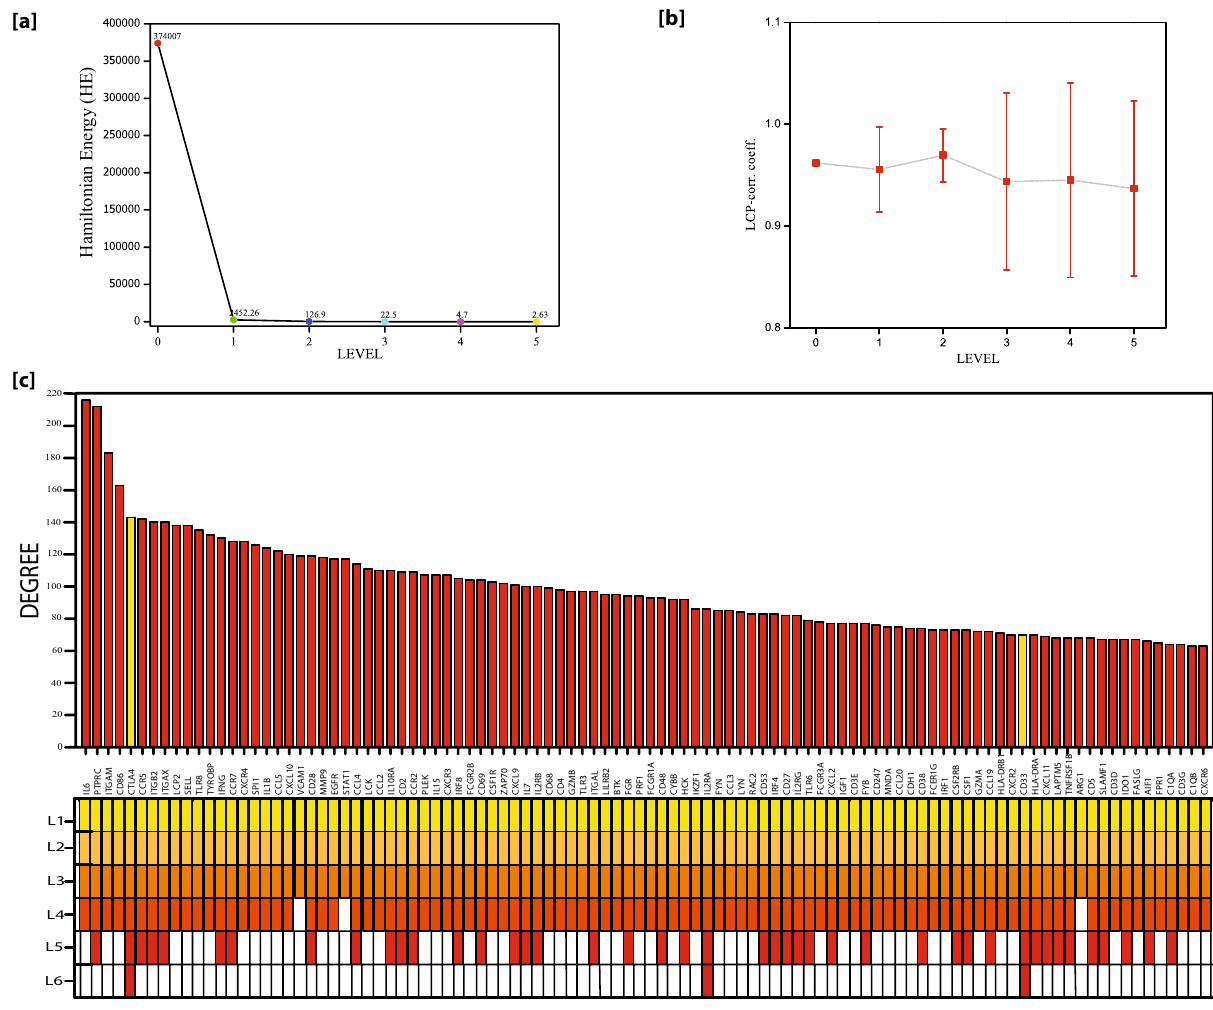
Figure 4. ( a ) Plots of Hamiltonian Energy as a function of level of organization. ( b ) Plots of LCP-corr as a function of the level of organization. ( c ) Characterization of top hundred leading hubs in the complete network by degrees; the plot also indicates unpredictability of these leading hubs at various levels of the organization. CTLA4 and CD33 are the key regulators presented by yellow